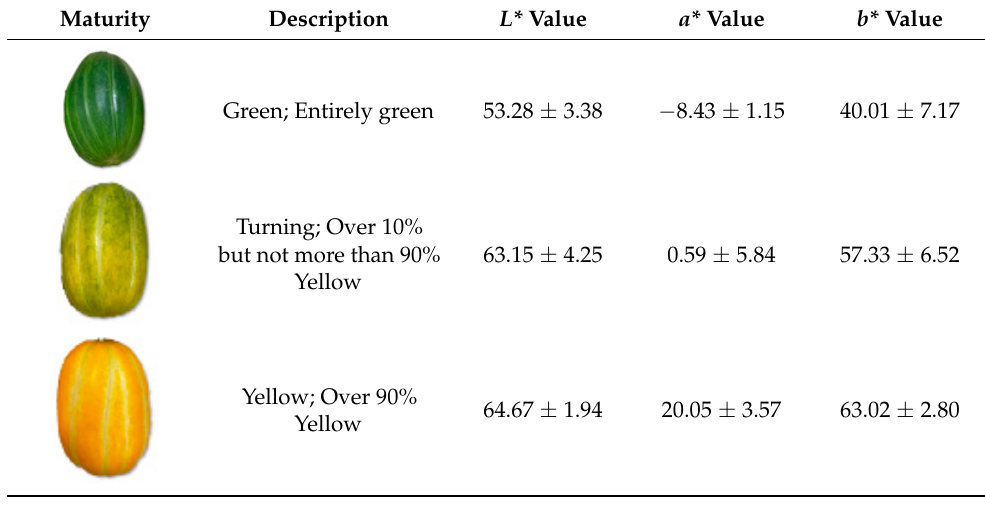
Table 1. Maturity stages of oriental melon fruits.